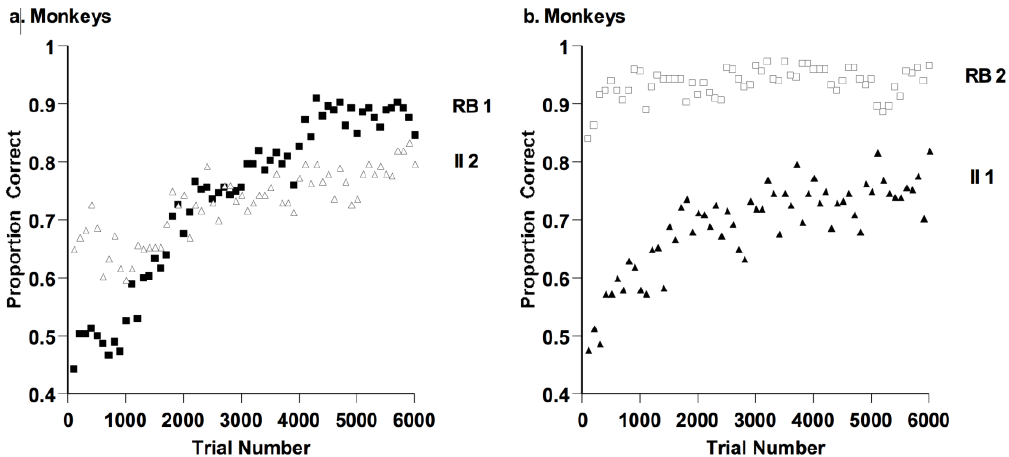
Figure 15. ( a ) Proportion of correct responses in each 100-trial block for three monkeys who performed 6000 trials of a rule-based (RB) and an information-integration (II) category task, in that order; and ( b ) proportion of correct responses in each 100-trial block for three monkeys who performed 6000 trials of an II and an RB category task, in that order. Reprinted from [58]. Copyright 2012 by Elsevier. Reprinted with permission.